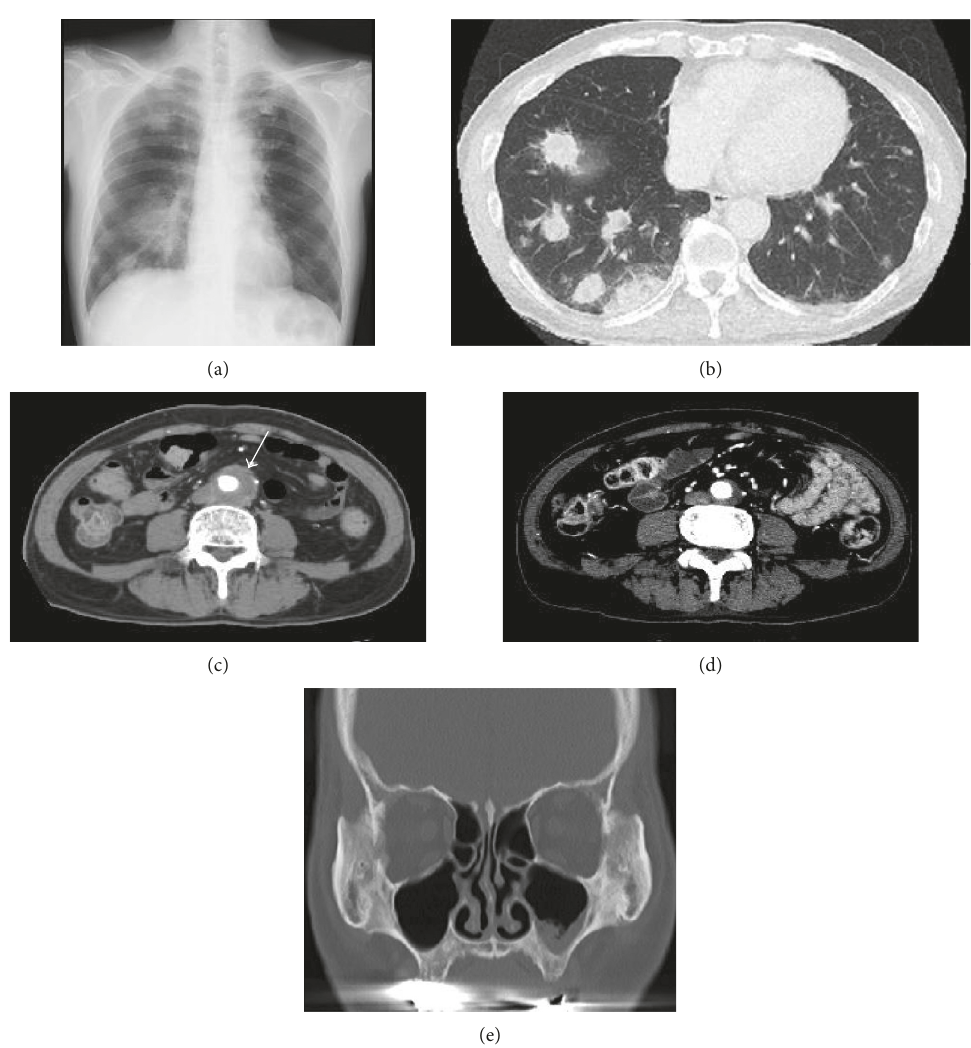
Figure 1: Chest radiograph and computed tomography (CT) of our patient with granulomatosis with polyangiitis. (a) Chest radiography demonstrating lung nodules. (b) CT of the chest showing lung nodules bilaterally. (c) CT of the abdomen showing a localized abdominal aortic aneurysm with a periaortic soft tissue mass. (d) CT of the abdomen after treatment. (e) CT of the left maxillary